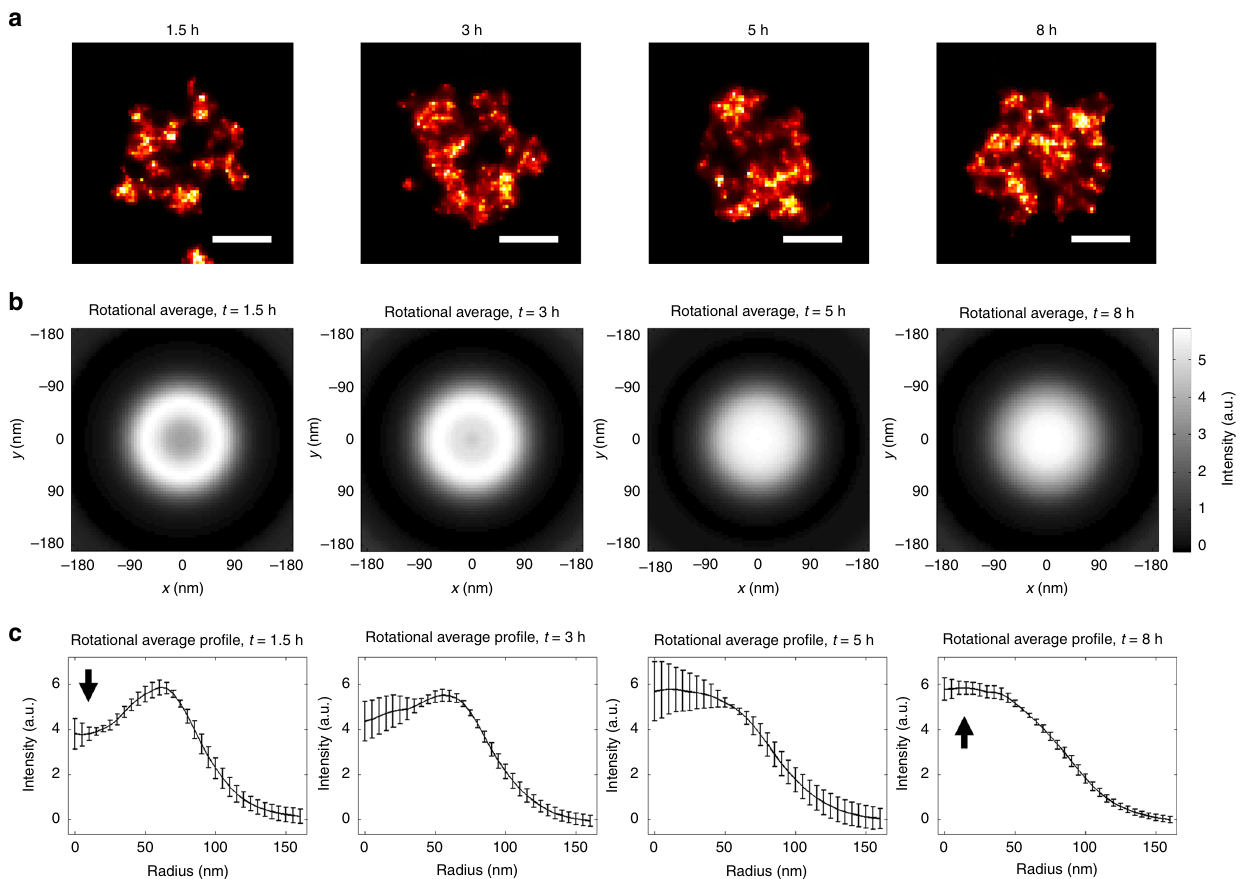
Fig. 2 Statistical analysis of CENP-A clusters in synchronized U2OS cells. a Manually picked representative clusters for each of the time points (1.5, 3, 5, and 8 h, shown on top); scale bars: 100 nm. b Rotationally averaged images of the sum of many aligned clusters for every time point. c Pro fi les of the rotationally averaged images shown in ( b ) with the standard deviation displayed with error bars. For this analysis, SMLM images of all centromeres from fi ve (1.5 – 5 h) or 6 (8 h) different cells were used: in total 211 clusters for the 1.5 h time point, 196 clusters for 3 h, 243 clusters for 5 h, and 214 clusters for 8 h. The error bars indicate the standard deviation between the rotationally averaged images of the sum of the CENP-A clusters of each analyzed cell for the given time point. The analysis shows that the density distribution progresses from a shell to a more compact sphere shape exhibiting a dip at the beginning of the radial pro fi le at 1.5 h (arrow) and a maximum at 8 h (arrow); see Source Data fi